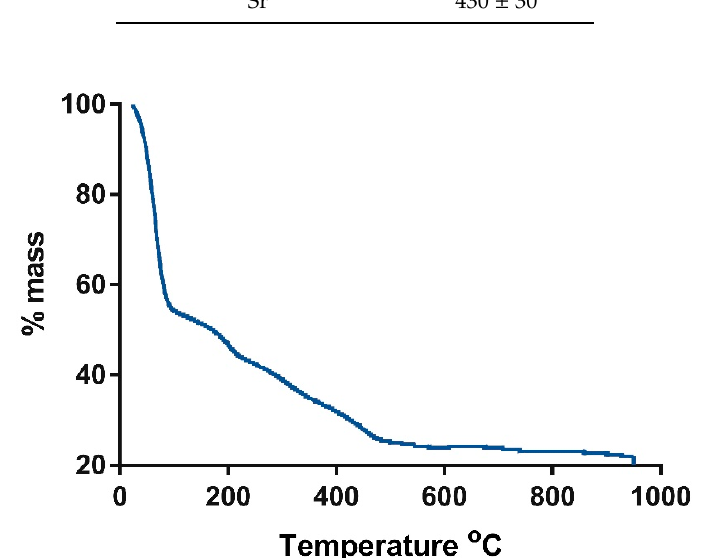
Figure 2. Thermogravimetric analysis of produced water (PW) particles. Four distinct groupings were determined: 1) Loss of water and volatile organics until 100 °C; 2) loss of larger organic molecules such as gas and diesel range compounds up to 500 °C; 3) primarily the loss of decomposing inorganics, such as calcium carbonate, above 500 °C; 4) residual inorganics, such as iron oxides and dirt.